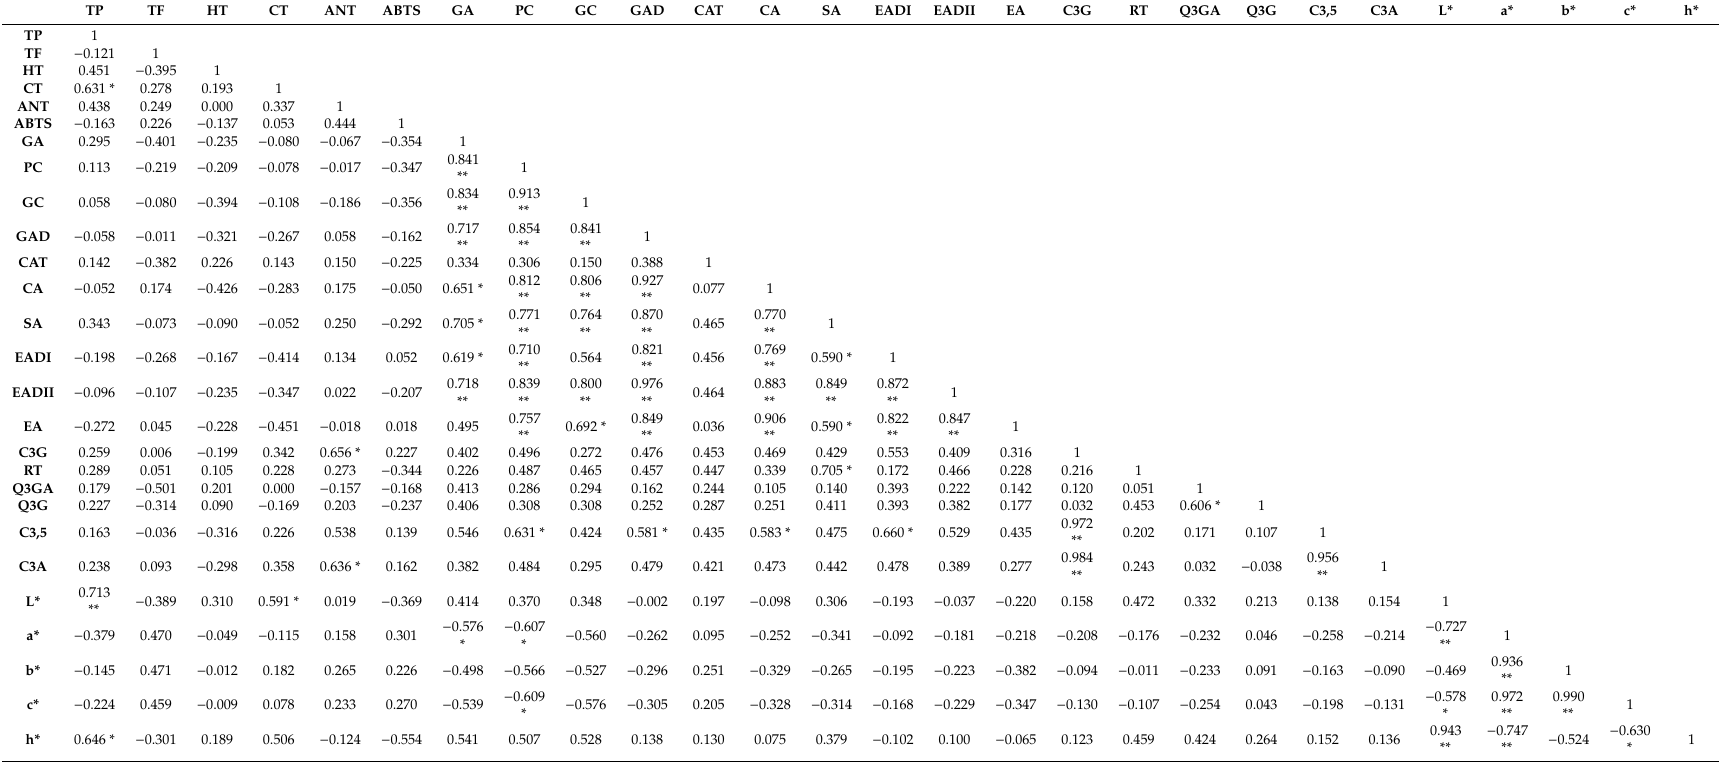
Table 6. Correlation coe ffi cients among biochemical parameters